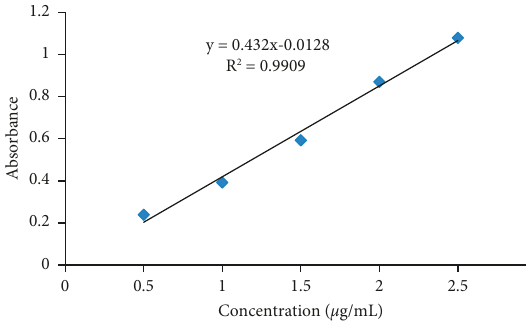
Figure 1: Standard calibration curve of